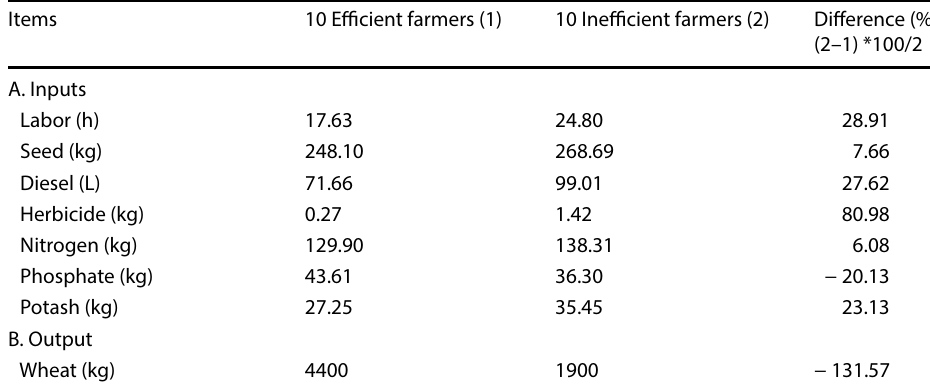
Table 8 Input and output quantities for most efficient and most inefficient farmers